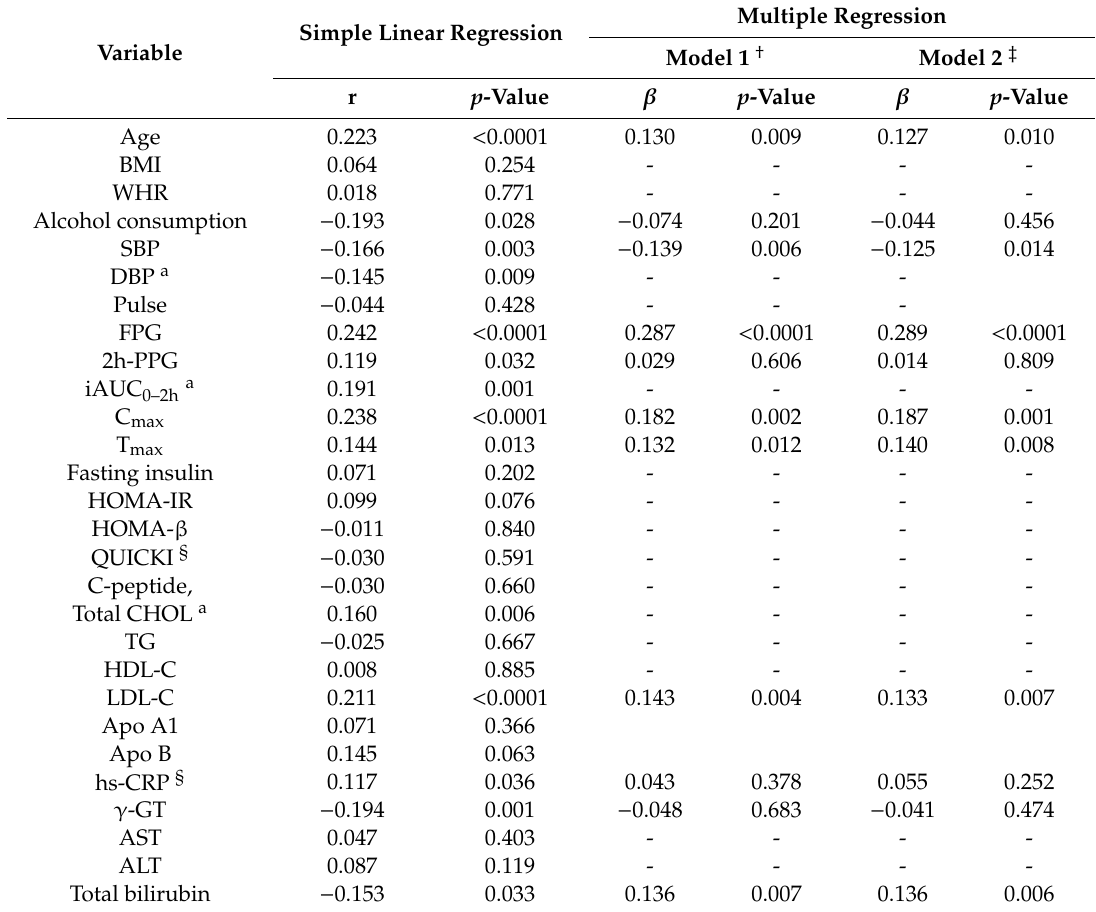
Table 6. Factors related to elevating HbA1c levels in subjects with